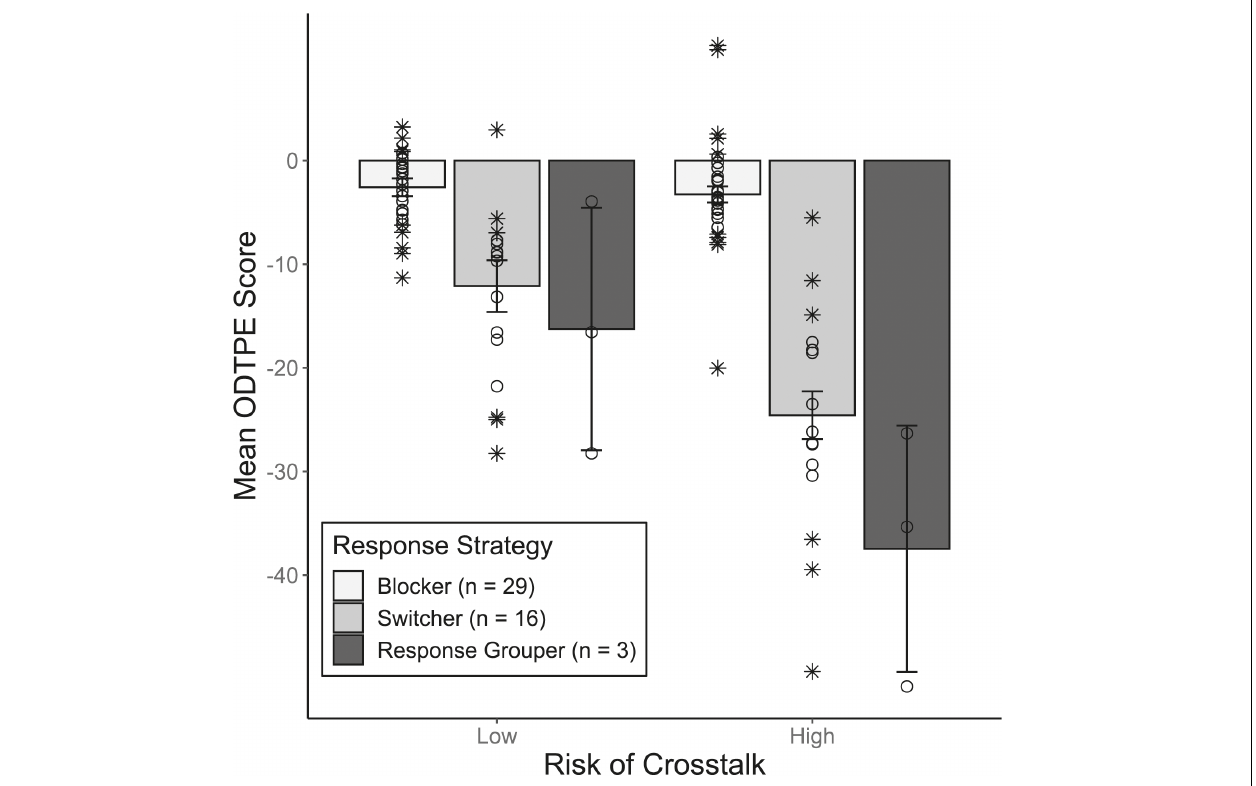
FIGURE 4 | Mean overall dual-task performance efficiency (ODTPE) scores of each response-strategy group in both crosstalk conditions (calculated on trimmed means). Error bars indicate ± one standard error calculated on trimmed means, separately for each Group × Crosstalk Condition. Circles/crosses represent individual data included/excluded in the calculation of trimmed means (20%